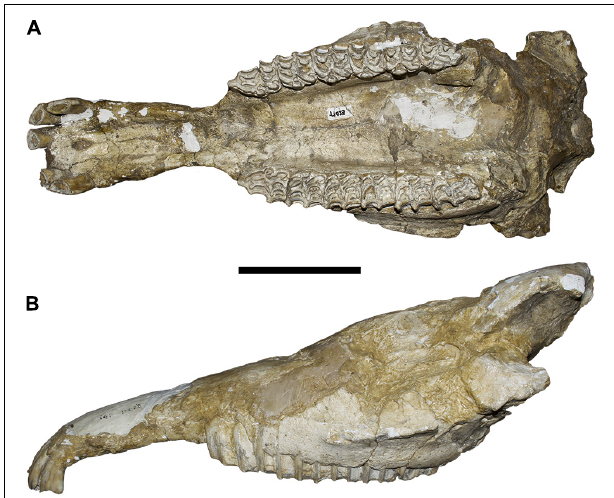
FIGURE 3 | Equus stenonis IGF11023, from the Early Pleistocene locality of Olivola. (A) Ventral view; (B) lateral view, left side. Scale bar 10